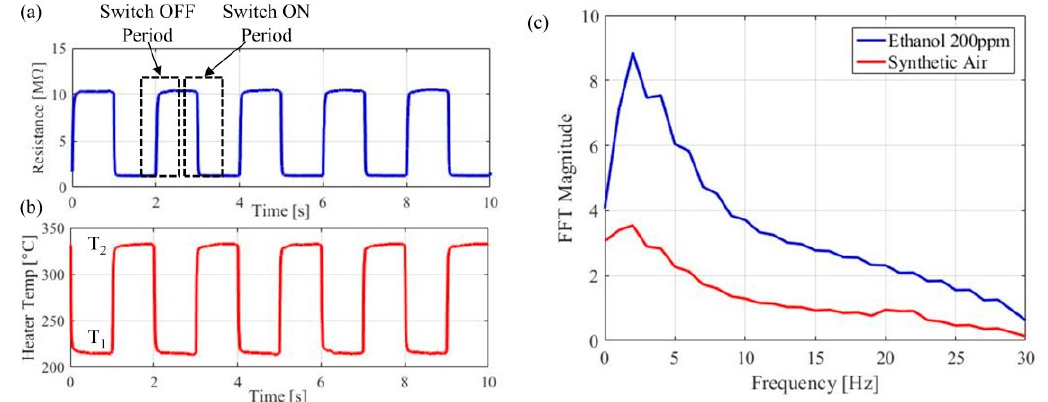
Figure 2. Signal processing method used during thermal modulation, ( a ) Sensor is thermally modulated between two temperatures, resistance shown of MOX sensor in synthetic air when temperatures are as shown in ( b ). 0.5 s period of data captured during exposure to synthetic air and ethanol at 200 ppm. FFT is calculated (on a microcontroller) from SnO 2 sensor data, as shown in ( c